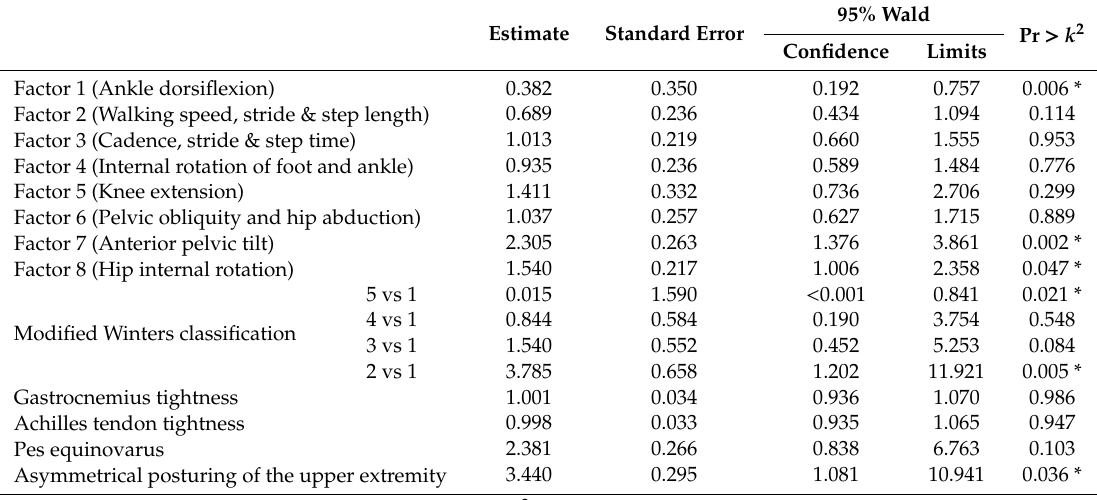
Table 6. Multivariate logistic regression analysis with gait and clinical